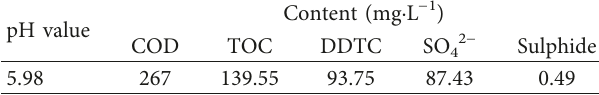
Table 2: Analysis results of the true beneficiation wastewater. pH value